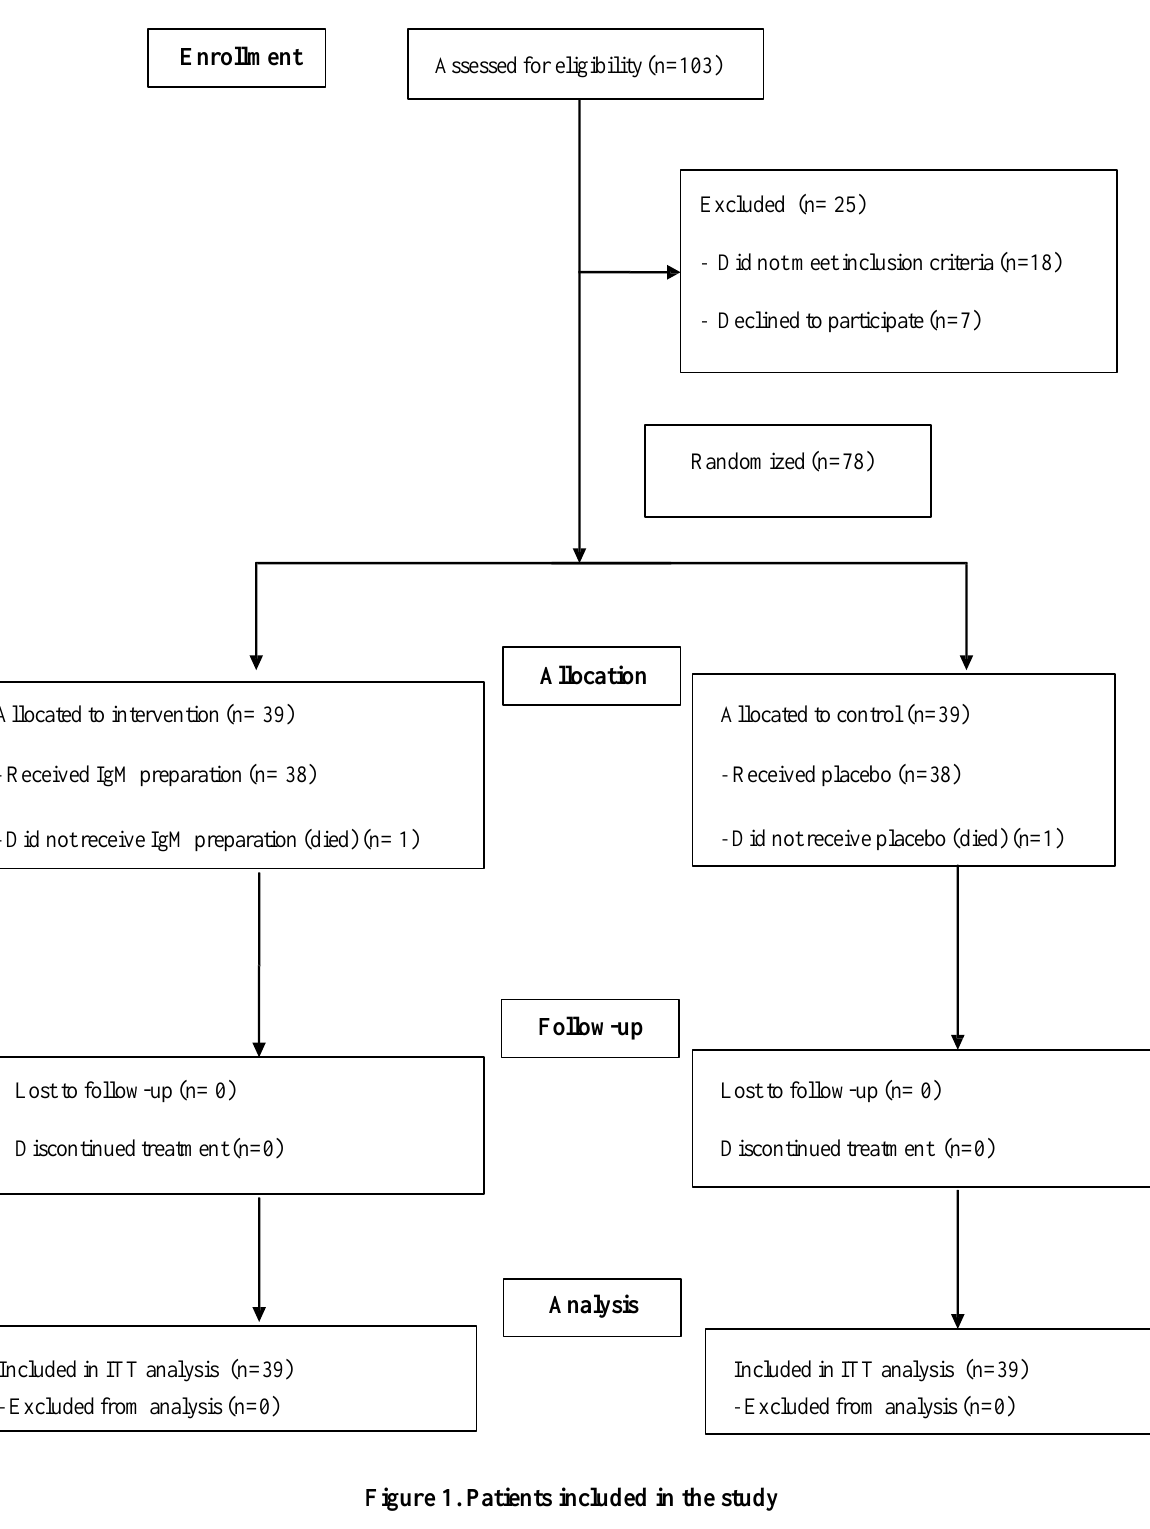
Figure 1. Patients included in the